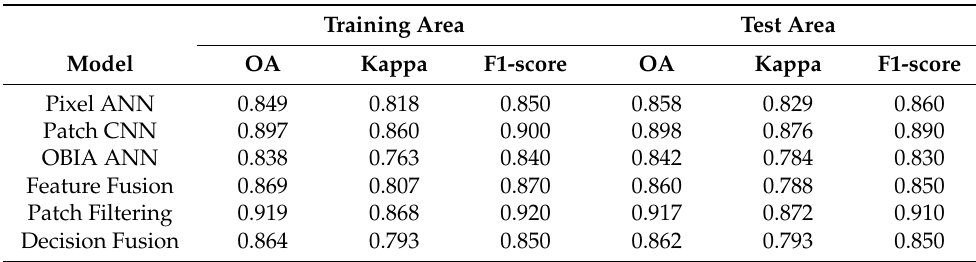
Table 5. Accuracy assessment of the classification methods used in this research for the training and test areas.